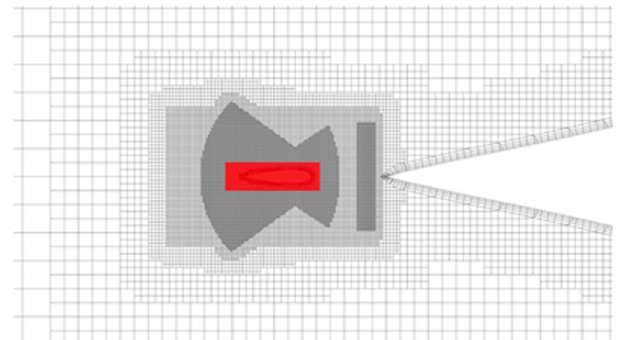
Figure 2 . Overset grid area of rudder area.